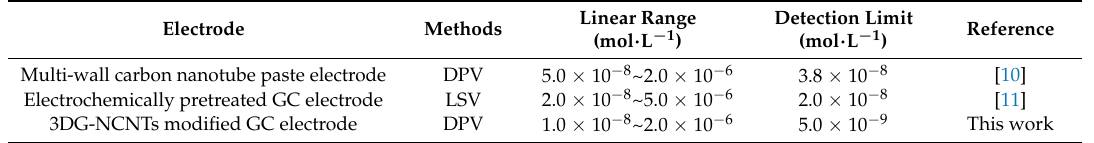
Table 1. Comparison of determination of urapidil by the different sensing methods reported. Electrode